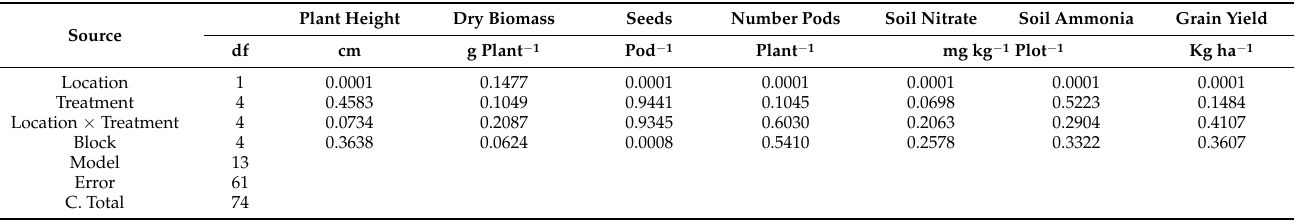
Table 4. Analysis of variance of site, treatments, their interactions, and block for yield and yield components of mung bean and difference in soil N as nitrate and ammonia, from planting to